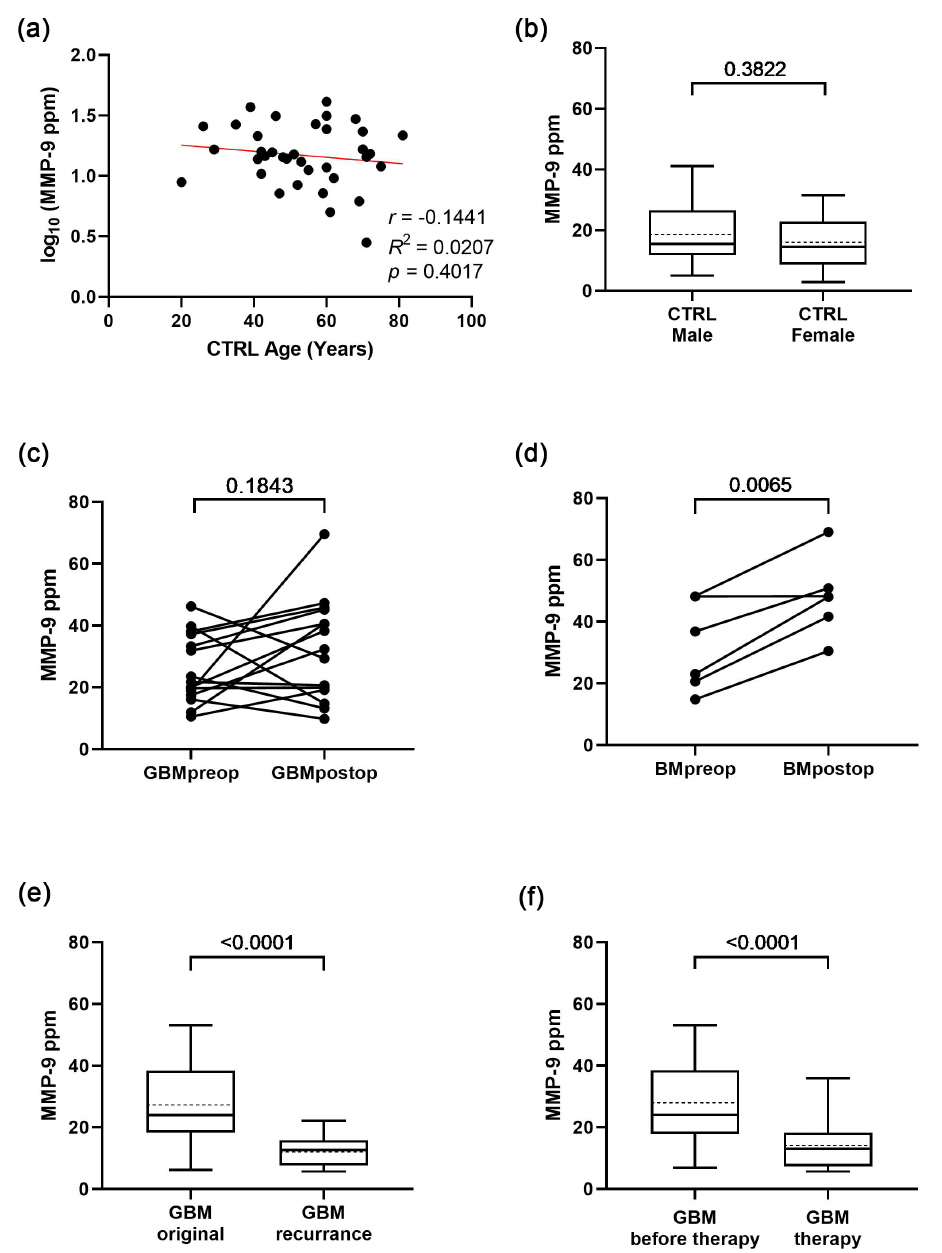
Figure 2. Factors influencing MMP-9 level of serum-derived sEVs . ( a ) Relationship between age and MMP-9 levels in the control group. (nCTRL = 36). ( b ) MMP-9 levels of the two genders in the control group (boxplots show the median with interquartile range, mean with dotted line, error bars range from the 5th–95th percentiles; nCTRL male = 16, nCTRL female = 20). ( c , d ) Changes in individual patient’s MMP-9 levels before and after surgical resection for the GBM and BM groups, respectively (nGBM preop-postop = 14, nBM preop-postop = 6). ( e ) MMP-9 levels of serum-derived sEVs regarding the original tumour and the recurrence in GBM group before surgical resection (nGBM original = 52, nGBM recurrence = 14). ( f ) MMP-9 levels in GBM group to treatment status (nGBM before therapy = 52, nGBM therapy = 15).